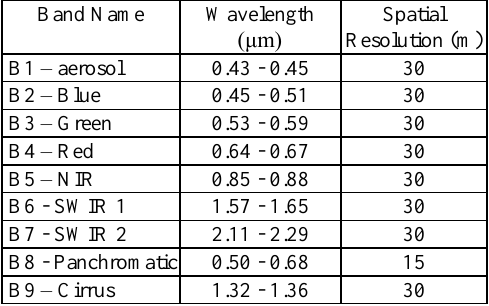
Table 1: LANDSAT-8 (OLI) Sensors and Band Names